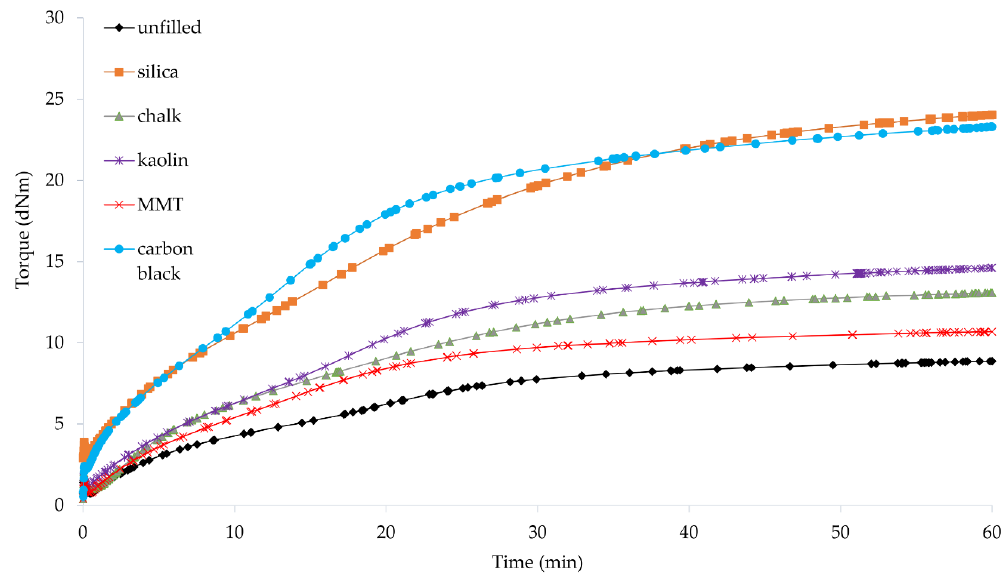
Figure 4. Vulcametric kinetics of filled CR cross-linked with copper(II) oxide (3 phr of CuO).